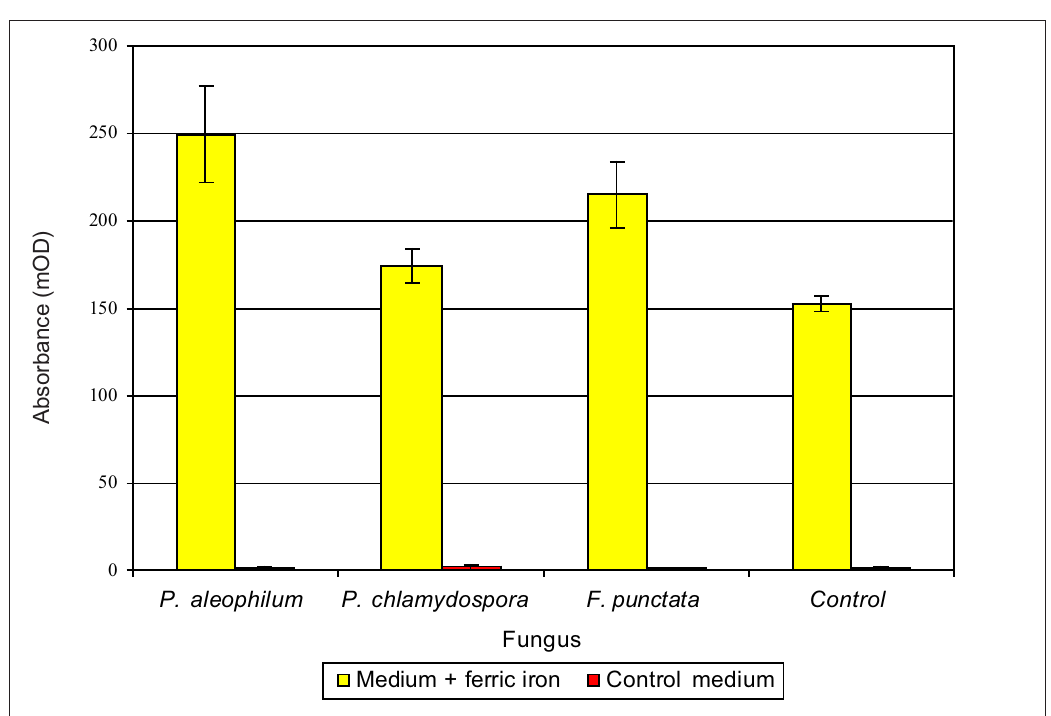
Fig. 1. Ferrous iron concentration in slighly modified Higley liquid medium after growth of esca-associated fungi, Phaeomoniella chlamydospora, Phaeoacremonium aleophilum and Fomitiporia punctata . Samples were collected at 24 days from fungal inoculation. Bars represent